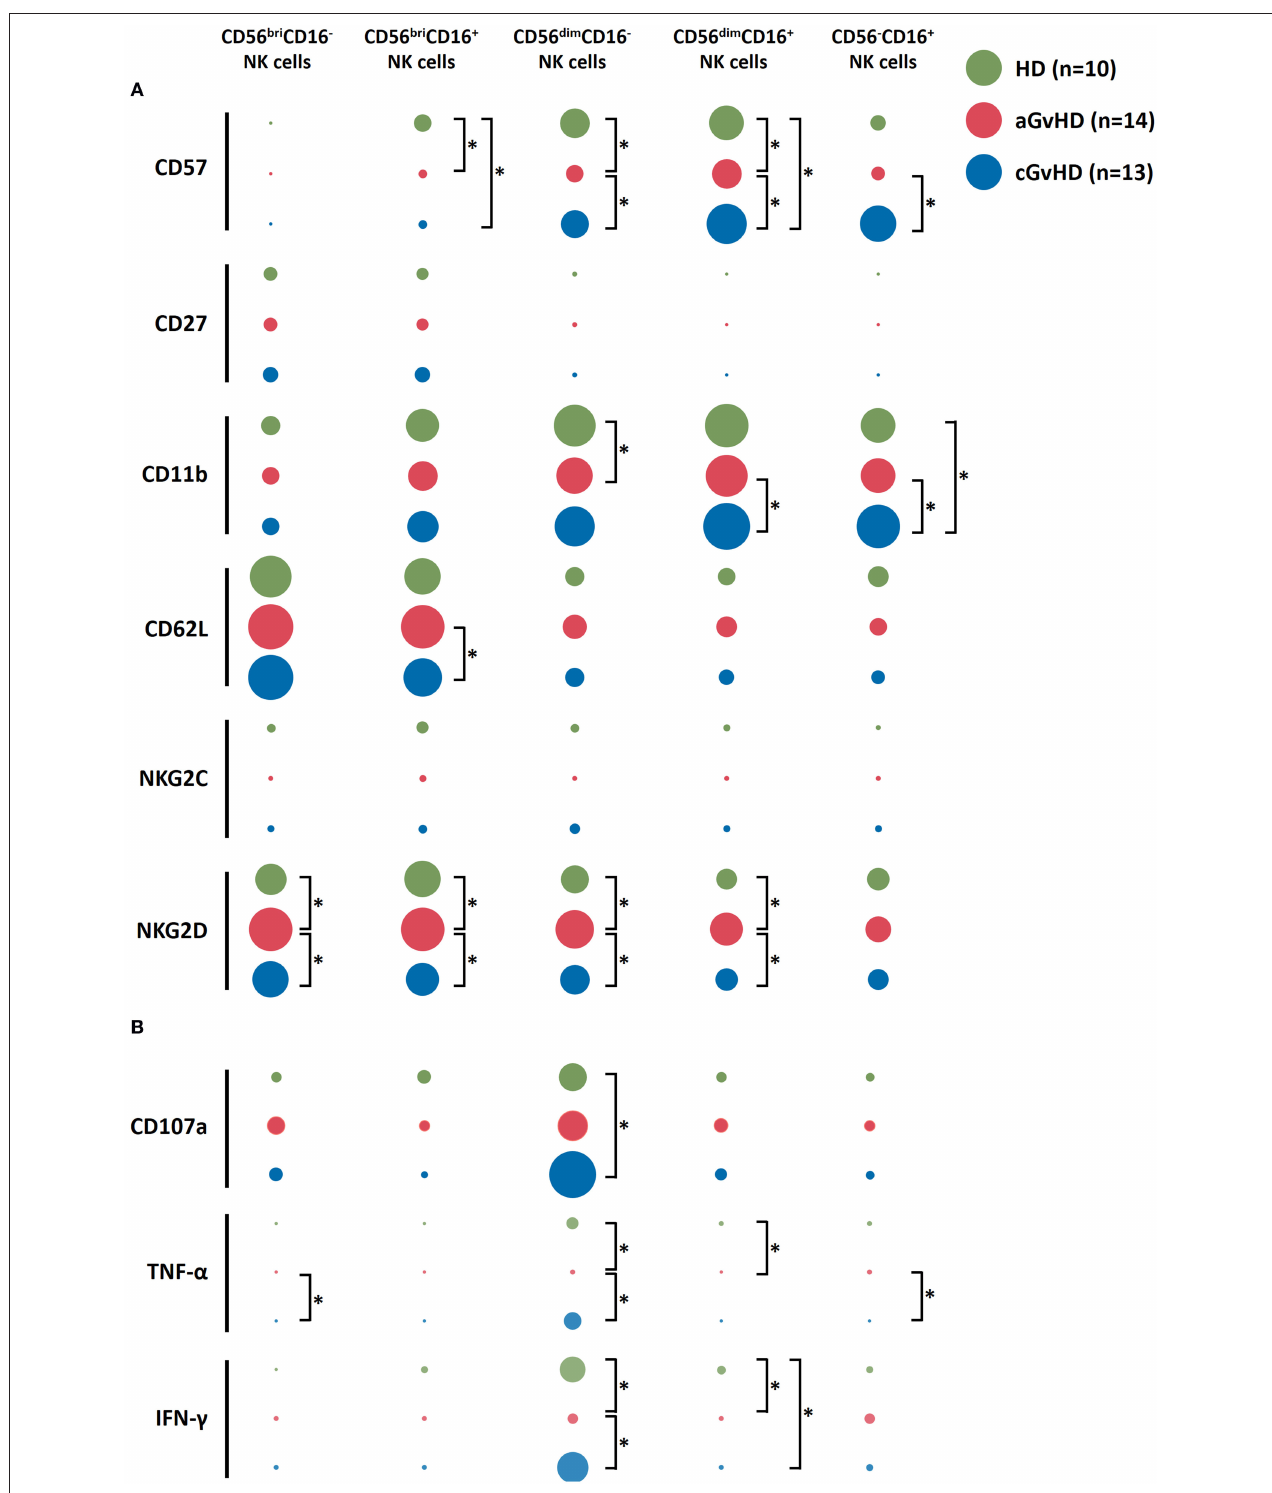
FIGURE 2 | Characterization of NK subsets. NK subsets display not a distinct immunophenotype based on the surface markers expression (A) but also a different functional profile upon K562 stimulation (B) among aGVHD ( n = 14, excluding patient #5 and #8 due to the limited cell number of samples), cGVHD ( n = 13, excluding patient #17, #18, #21, #22, and #25 due to the limited cell number of samples) and HD groups ( n = 10). The figure was drawn by Excel software with “EasyCharts” package. The data were normalized automatically by the software. The diameter of the bubble presents the mean value of the percentage of the expression of each marker. * p <